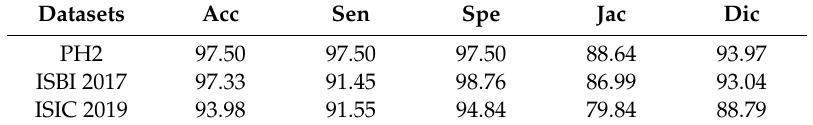
Table 8. Segmentation performance (%) of iteration II. Figure 13. ( a ) Input images (IMD285, ISIC_0013617 and ISIC_0059197), ( b ) output image after hair removal and enhancement, ( c ) location detection by YOLOv3, ( d ) segmented image after iteration I, ( e ) segmented image after iteration II (final segmented output).